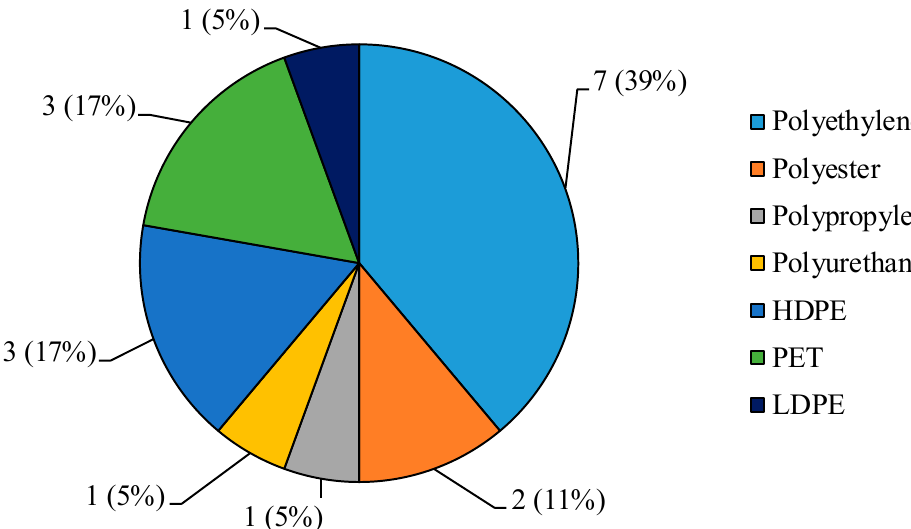
Figure 2. Number of microplastics (MPs) grouped per polymeric composition (% on the total amount of MPs) isolated from snow samples collected in four locations of the Aosta Valley (Western Italian Alps). HDPE = High-density Polyethylene; LDPE = Low-density Polyethylene; PET = Polyethylene terephthalate.